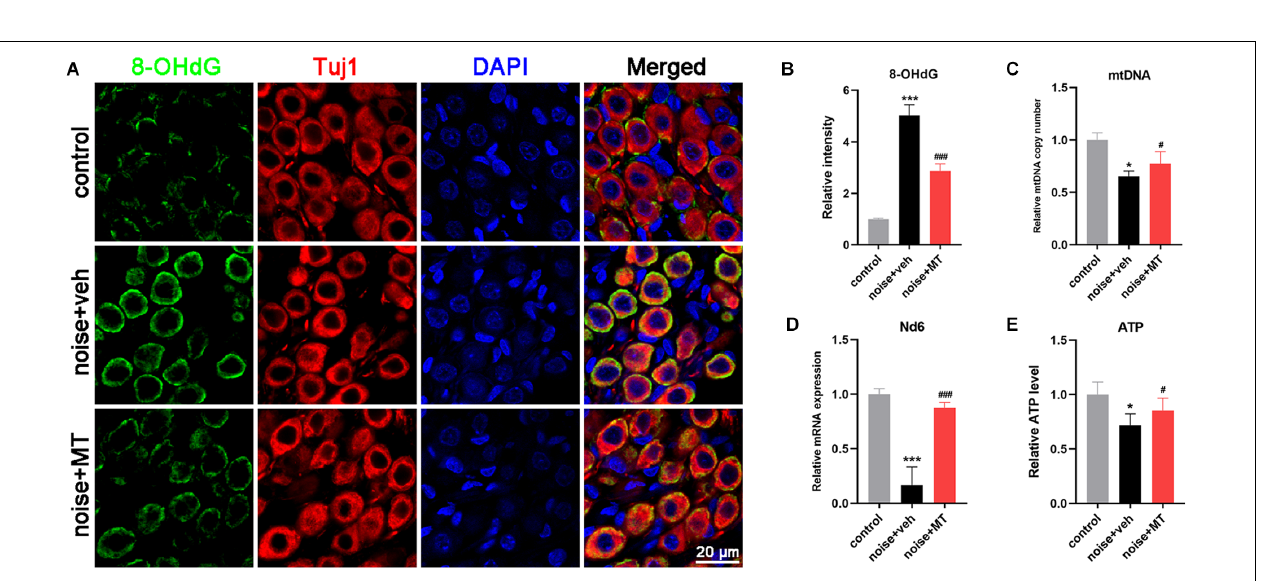
FIGURE 6 | MT treatment alleviated mtDNA oxidative damage, and maintained mitochondrial biogenesis and ATP production after the acoustic trauma. (A) Representative images of 8-OHdG (green), Tuj1 (red) and DAPI (blue) fluorescent staining in SGNs in frozen sections of the cochlea 1 h after the noise exposure. (B) Semi-quantitative analysis of the fluorescent intensity of 8-OHdG in SGNs 1 h after the noise exposure. (C) Real time-qPCR analysis of mtDNA copy number in the cochlea 3d after the noise exposure. (D) Real time-qPCR analysis of mitochondrial Nd6 expression level in the cochlear 1 h after the noise exposure. (E) The ATP level in the cochlea 1 h after the noise exposure. Data are presented as means ± SD, n = 4 for each group, * p < 0.05 vs. control group, *** p < 0.001 vs. control group, # p < 0.05 vs. vehicle-treated group, ### p < 0.001 vs. vehicle-treated